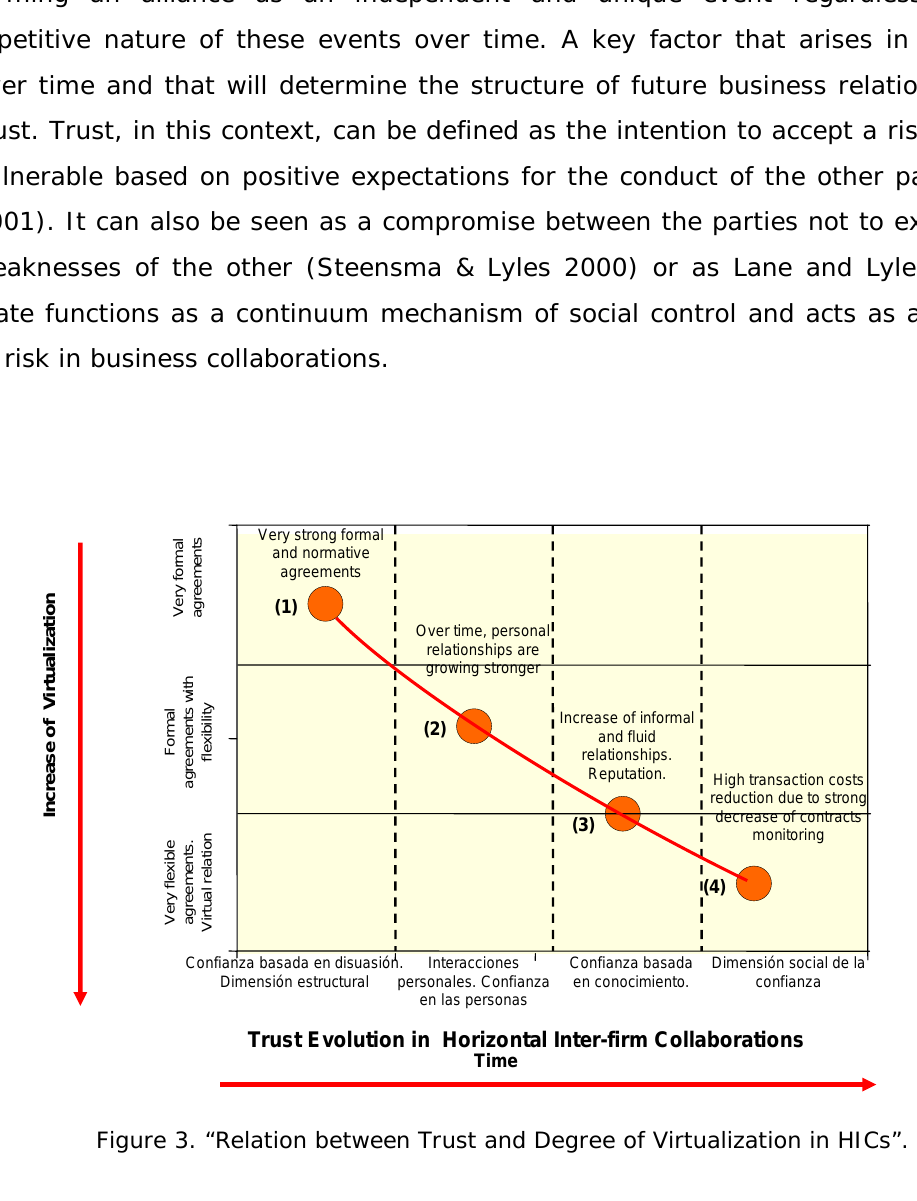
Figure 3. “Relation between Trust and Degree of Virtualization in